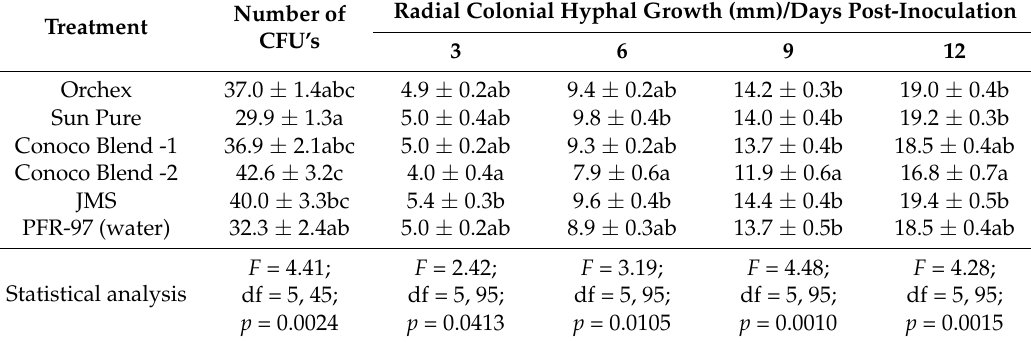
Table 2. The mean number ( ± SEM) of colony forming units (CFUs) and radial colonial hyphal growth (mm) of Isaria fumosorosea (PFR-97), alone or mixed with various HMO treatments at 25 ± 1 ◦ C, 60–80% RH, under a 12:12 h L:D photoperiod assessed in vitro over 12